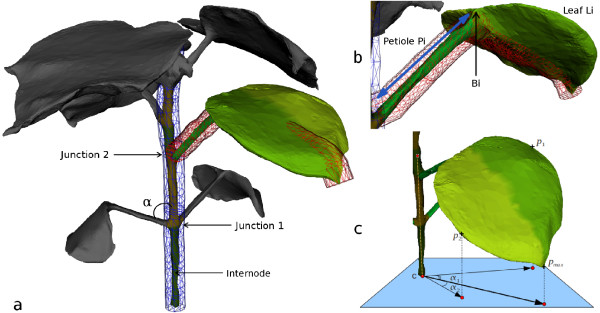
Schematic illustration of the segmentation.(a) shows the tubes used to segment the stem (blue) and one petiole (red). (b) illustrates the tube used to separate (segment) the petiole P
i
from the leaf L
i
. (c) illustrates the planar symmetry used to segment the leaf into two symmetric parts. In this particular case, the points p1and p2will belong to two different leaf regions as the angles α1and α2are signed differently .